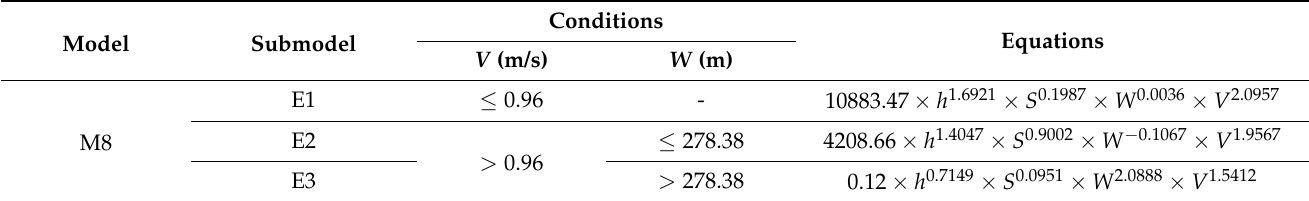
Table 8. Application conditions and determination coefficients of Model 8 (M8).